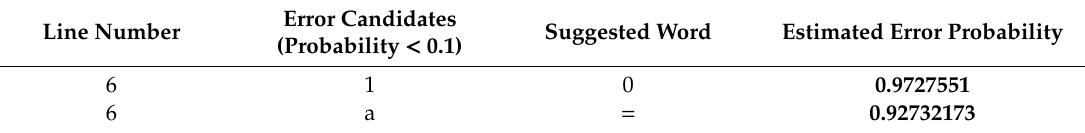
Figure 9. Logic error assessment and detection for source code evaluated using LSTM-AttM. Table 5. Estimated error probability for erroneous source code in Figure 9.